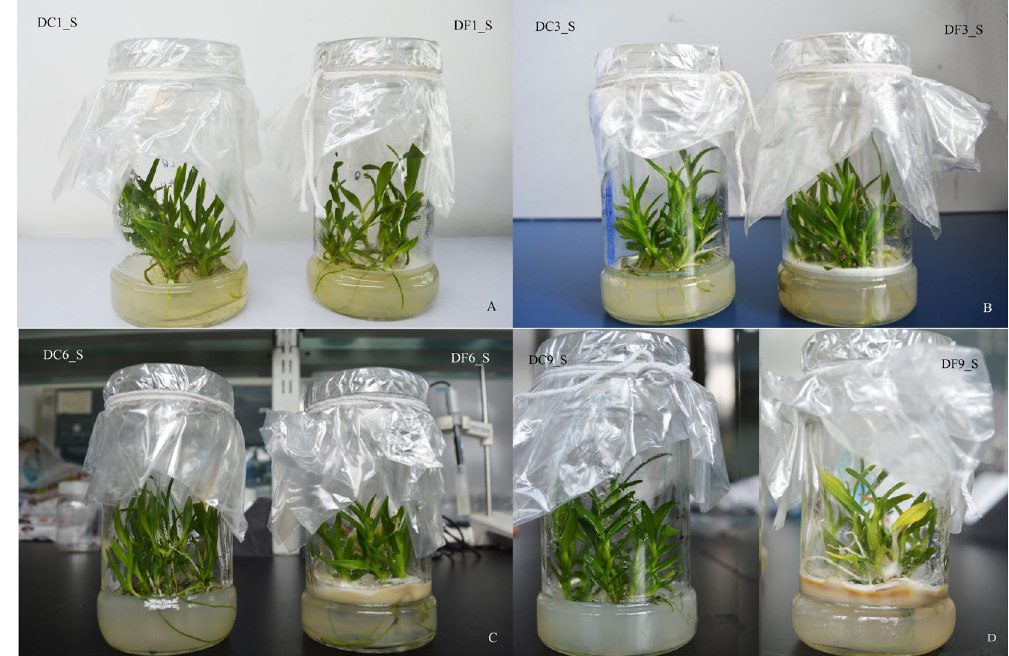
Figure 1. The effect of MF23 on the growth of D. nobile tissue culture seedlings ( A , B ). ( A ) D. nobile 1 week after inoculation (DF1_S) and the control (DC1_S). ( B ) D. nobile 3 weeks after inoculation (DF3_S) and the control (DC3_S). ( C ) D. nobile 6 weeks after inoculation (DF6_S) and the control (DC6_S). ( D ) D. nobile 9 weeks after inoculation (DF9_S) and the control